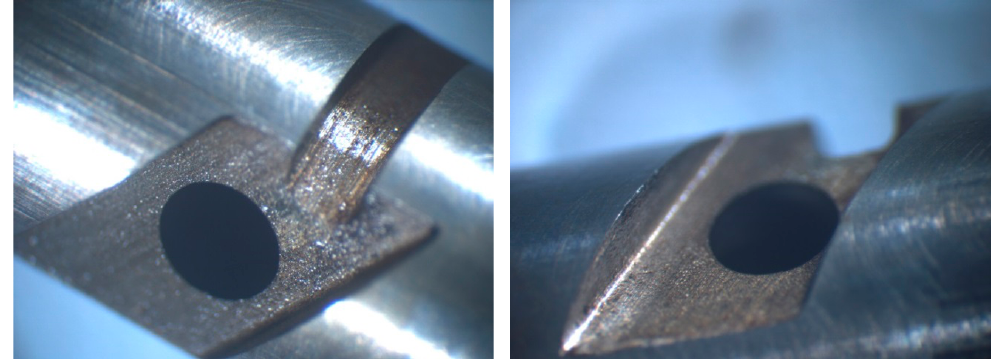
Figure 25. Details of wear on the plunger.